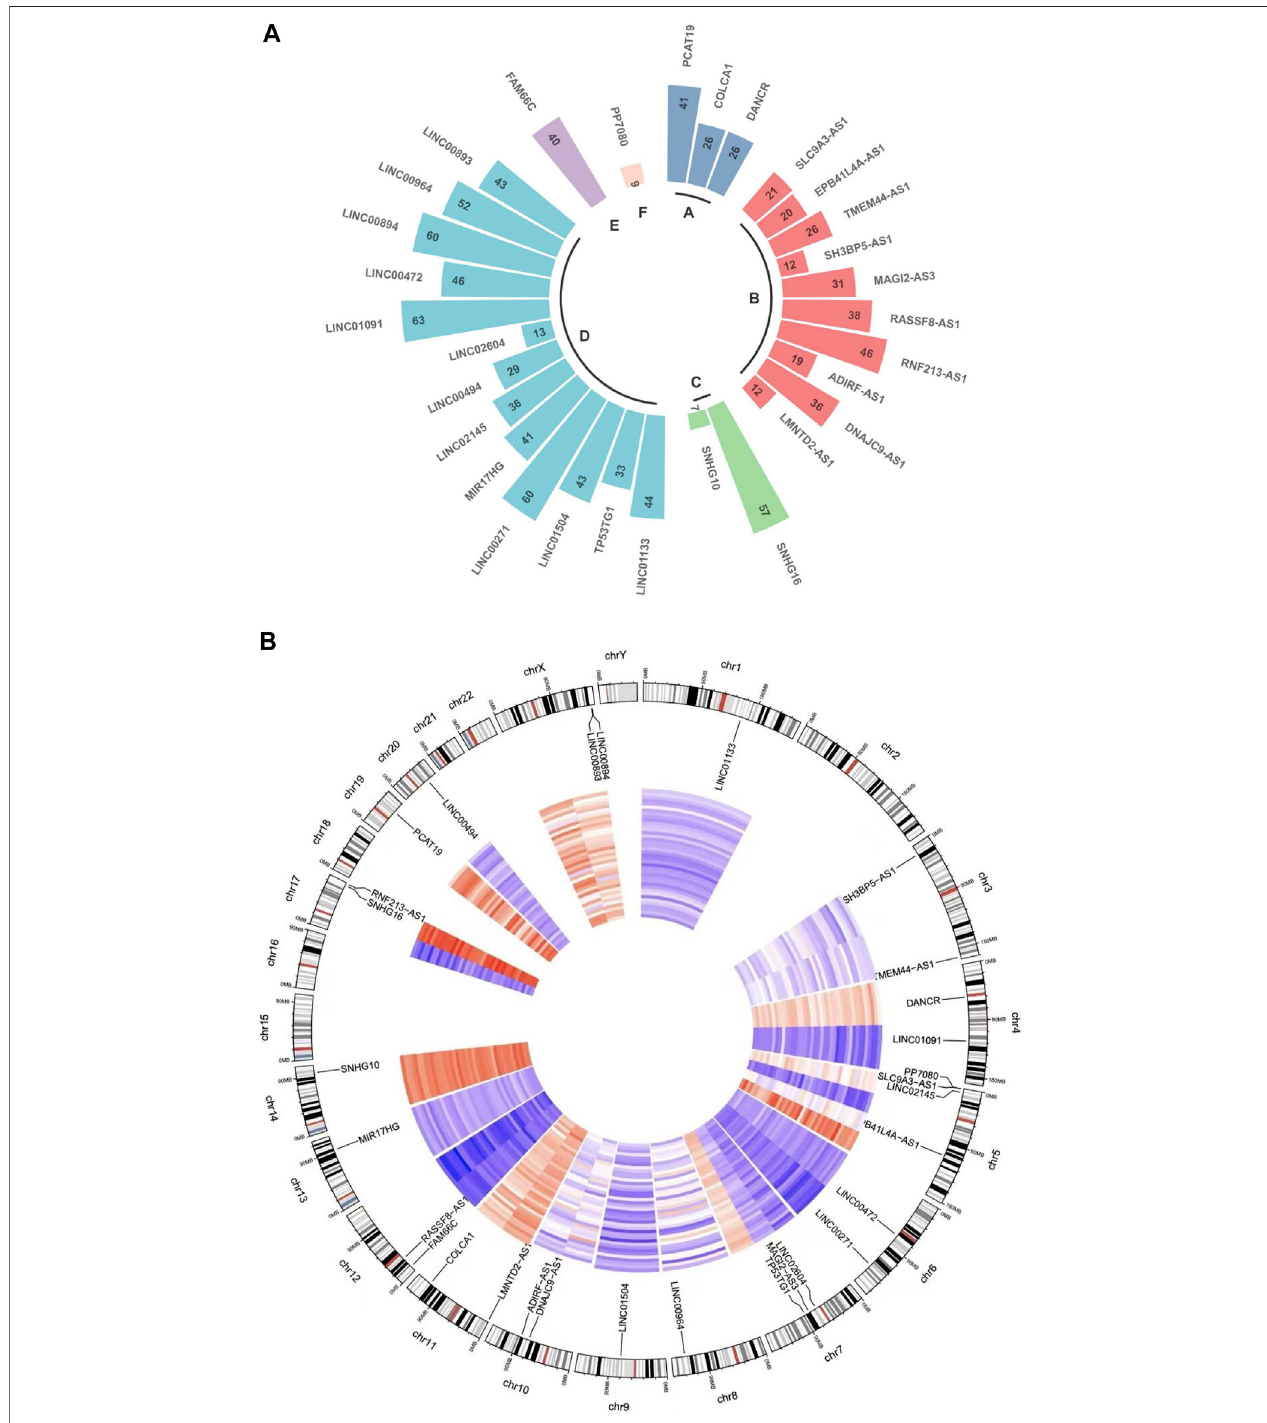
FIGURE3| LncRNAfunctionanddistributionineverychromosome. (A) CircularplotindicatesthelncRNAcountsandtypesaccordingtothedifferentiallyregulated lncRNA categorizations. The RNA lengths plotted in Log (1.1 kbp) scale. (A) : Long non-coding RNAs with non-systematic symbols. (B) : Antisense RNAs; (C) : Small nucleolar RNA non-coding host genes; (D) : Long intergenic non-protein coding RNAs; (E) : Long non-coding RNAs with FAM root symbol; (F) : Non-speci fi ed. (B) A circos diagram showing the location of the identi fi ed lncRNA pairs in the chromosome.